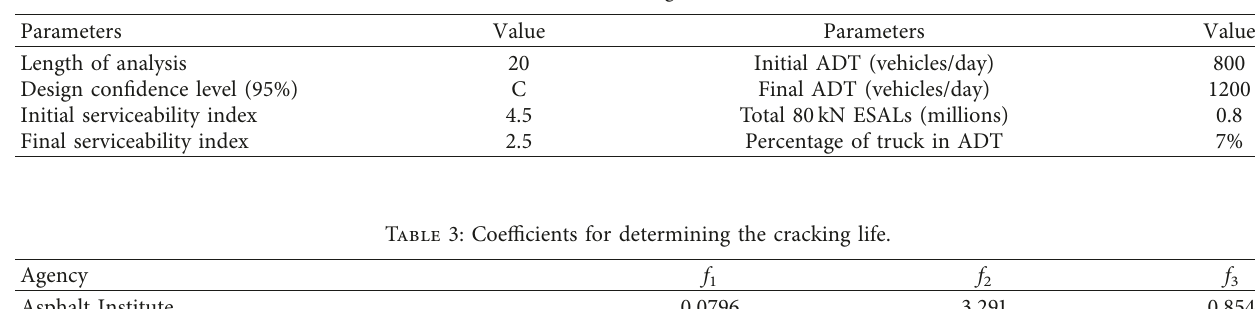
Figure 12: Pavement section. Note: EA is the elastic modulus of the asphalt layer; EB is the elastic modulus of the base layer; EL is the average modulus (U1–U10) back-calculated by LEM; EV is the average modulus (U1–U10) back-calculated by VEM. Table 2: Design data.